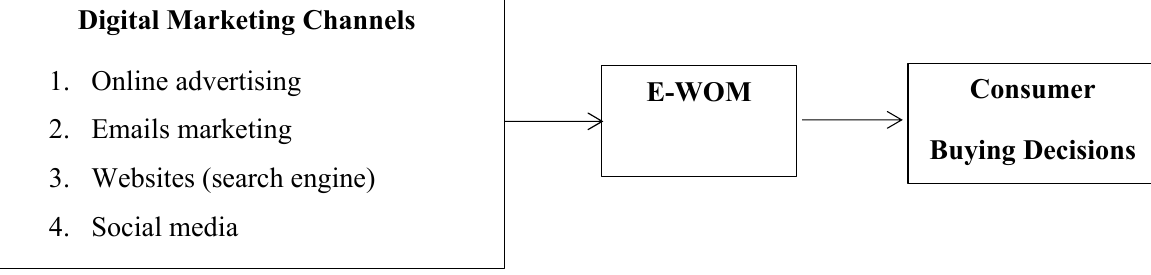
Fig. 1. Research Conceptual